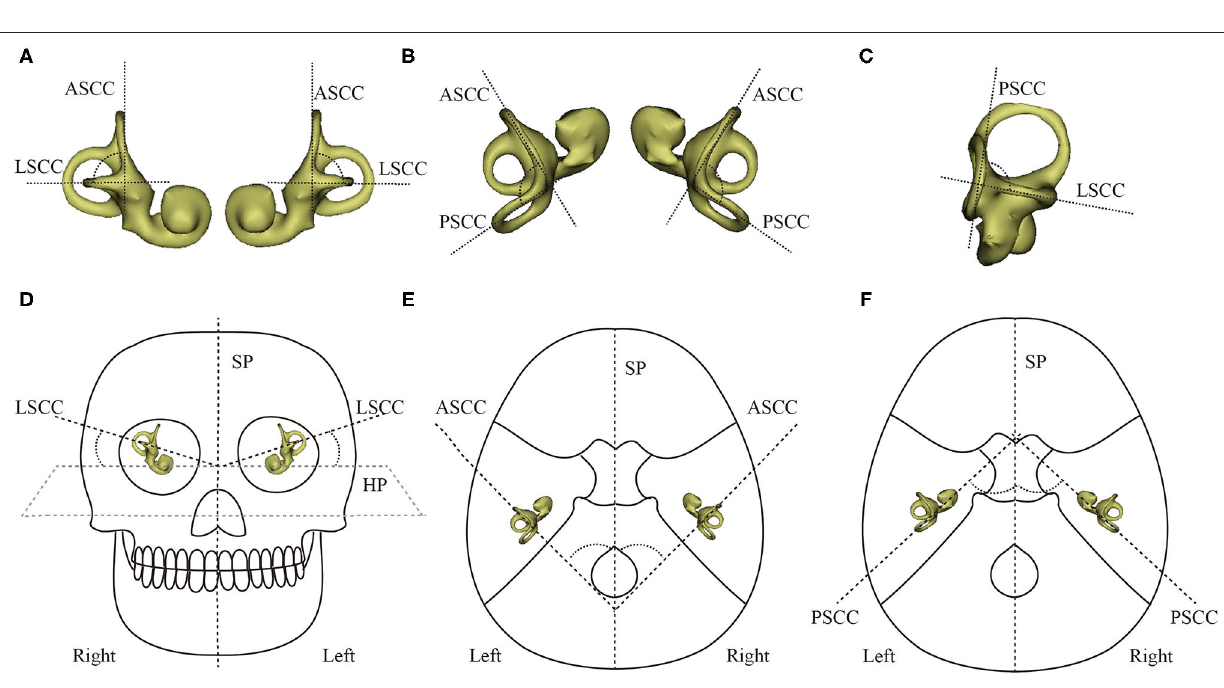
FIGURE 4 | The angles between the planes of the semicircular canals and between the canal planes and the imaging planes. (A) ASCC & LSCC. (B) ASCC & PSCC. (C) PSCC & LSCC. (D) 6 LSCC & HP. (E) 6 ASCC & SP. (F) 6 LSCC & SP. ASCC, PSCC, and LSCC refer to the anterior, posterior, and lateral semicircular canals, respectively; SP, HP, and FP, respectively, refer to the sagittal, horizontal, and frontal imaging